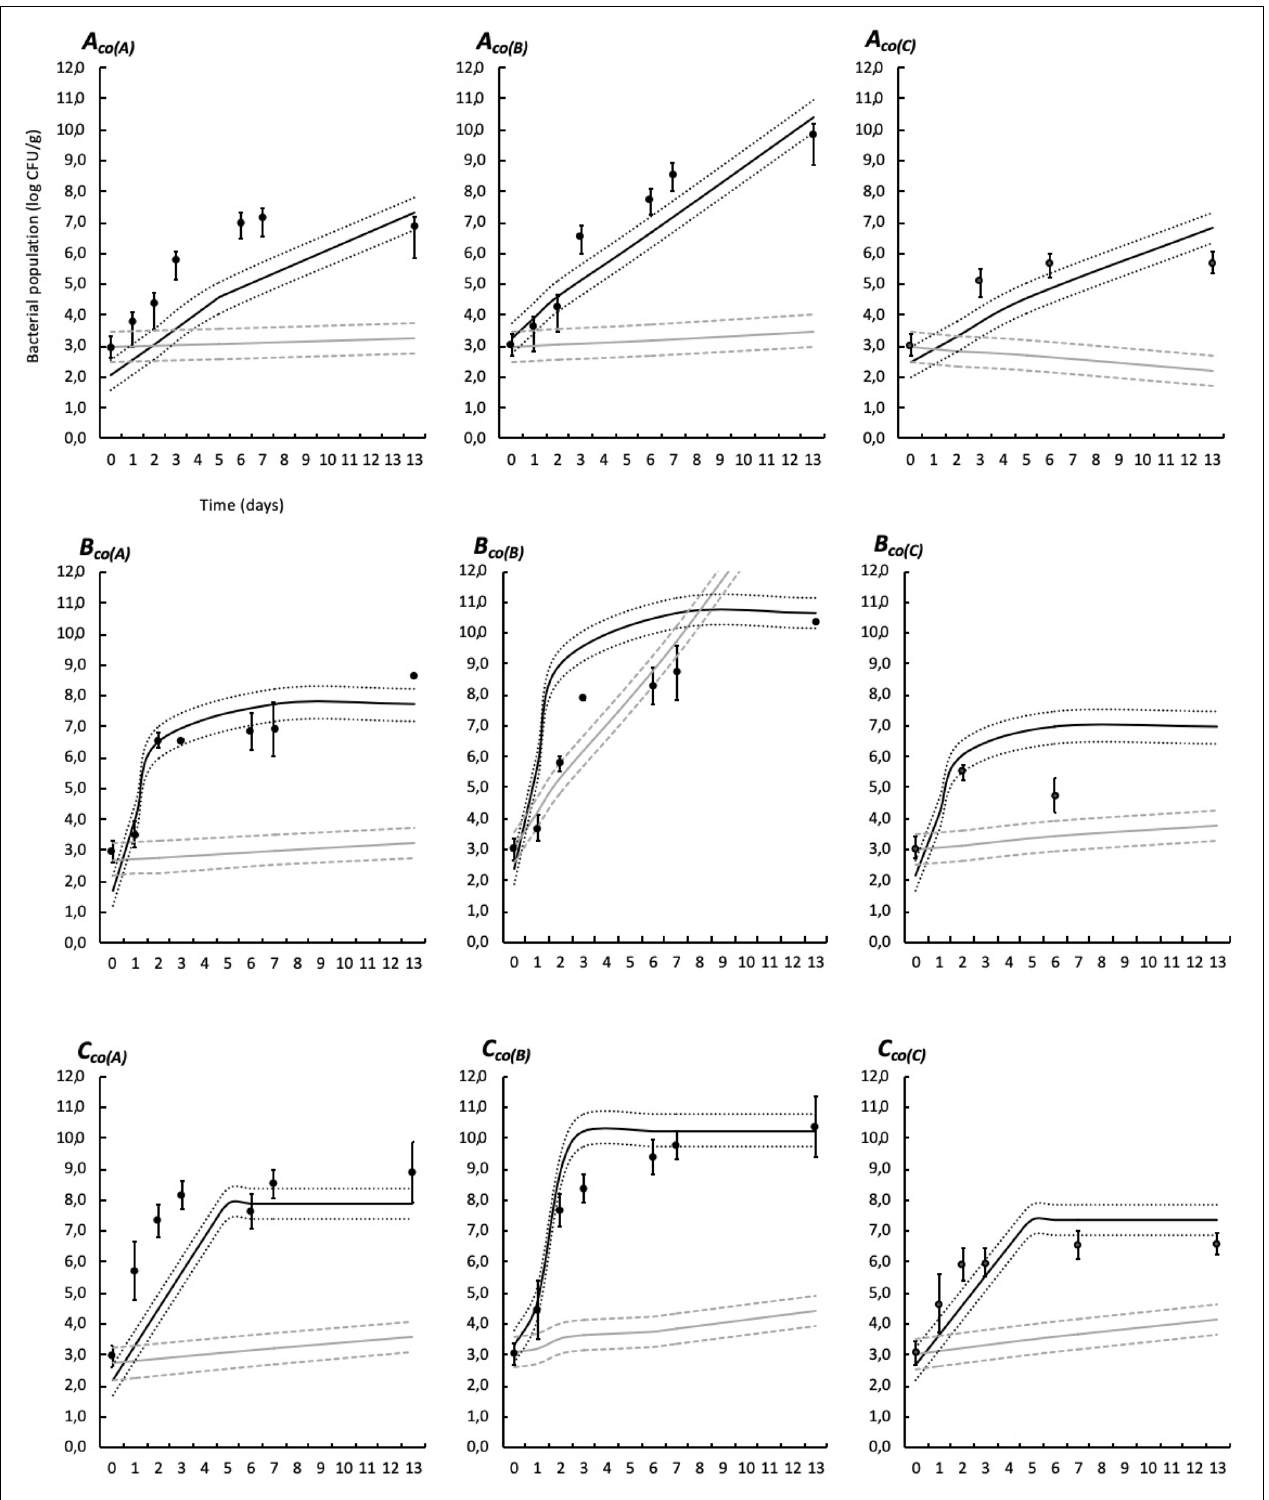
FIGURE 6 | Experimental observed data (validation dataset, means, and standard deviation of the three replicates) and simulations provided by the predictive models based on the modified Jameson-effect equation and on the Lotka Volterra equation in food wrap. See Table 1 for list of the codes used. Black solid lines represent the Jameson-effect model and gray solid lines represent the Lotka Volterra model. Dashed and dotted lines represent the acceptable simulation zone (ASZ) used to compare observations versus predictions of the interaction models.